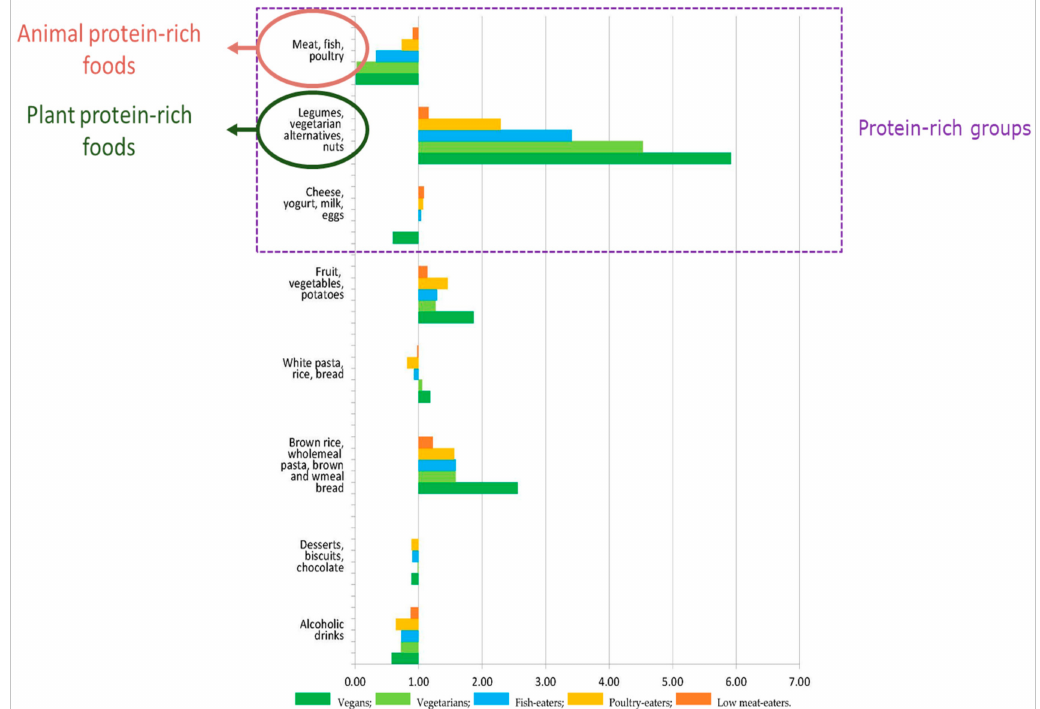
Figure 2. Relative consumption of food groups (g) in low meat-eaters, poultry-eaters, fish-eaters, vegetarian, and vegan men compared to regular meat-eaters in the EPIC-Oxford study. The mean consumption relative to regular meat-eaters (1.00) is shown for each food group after adjustment for age. Circled are intakes of animal or plant-protein rich food groups. Adapted from